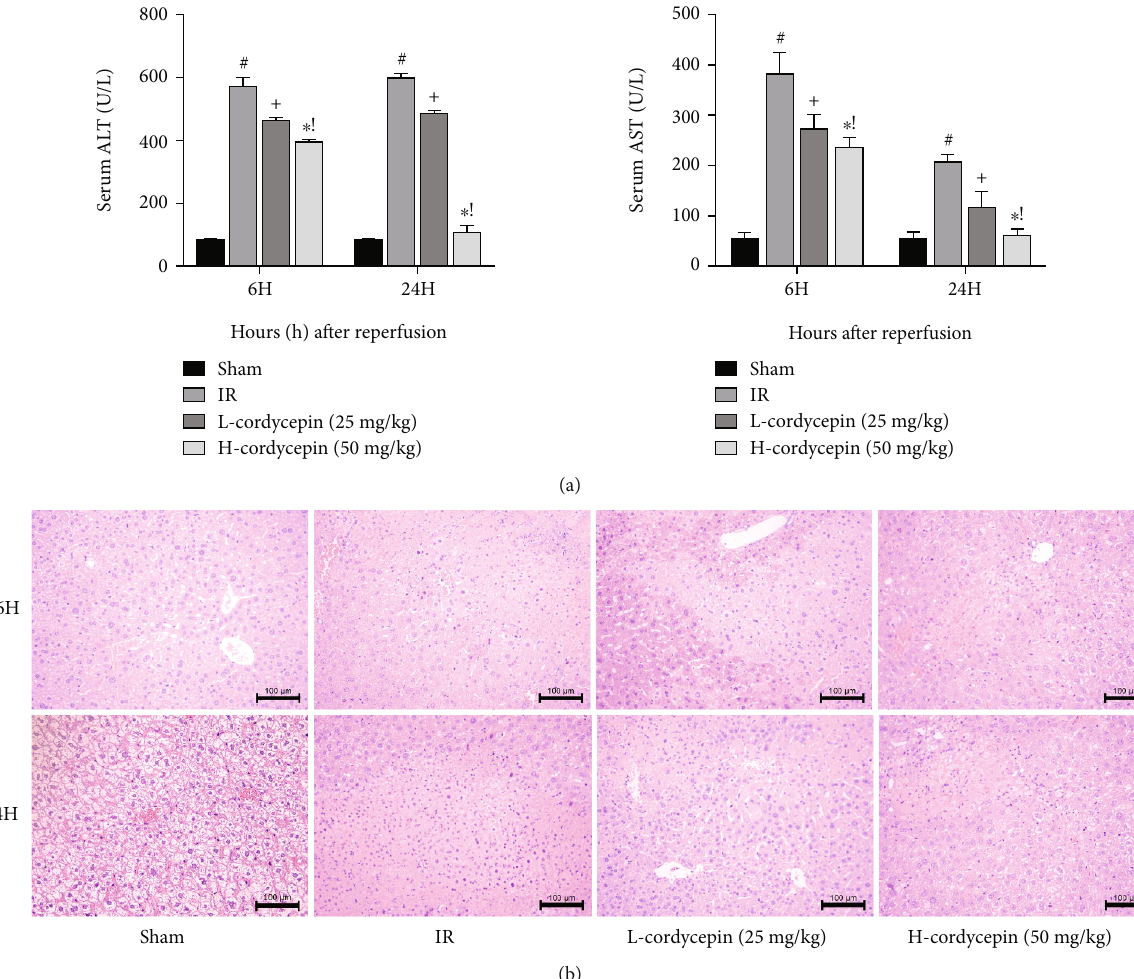
Figure 2: Cordycepin pretreatment could signi fi cantly alleviate liver injury after ischemia-reperfusion. Note: (a) the levels of serum ALT and AST were presented as mean ± SD ( n = 6 ; # p < 0 : 05 for IR vs. sham; + p < 0 : 05 for L-cordycepin (25 mg/kg) vs. IR; ∗ p < 0 : 05 for H-cordycepin (50 mg/kg) vs. IR; ! p < 0 : 05 for L-cordycepin (25 mg/kg) vs. H-cordycepin (50 mg/kg)). (b) Representative H&E-stained hepatic sections were examined under light microscopy and imaged at × 200 magni fi